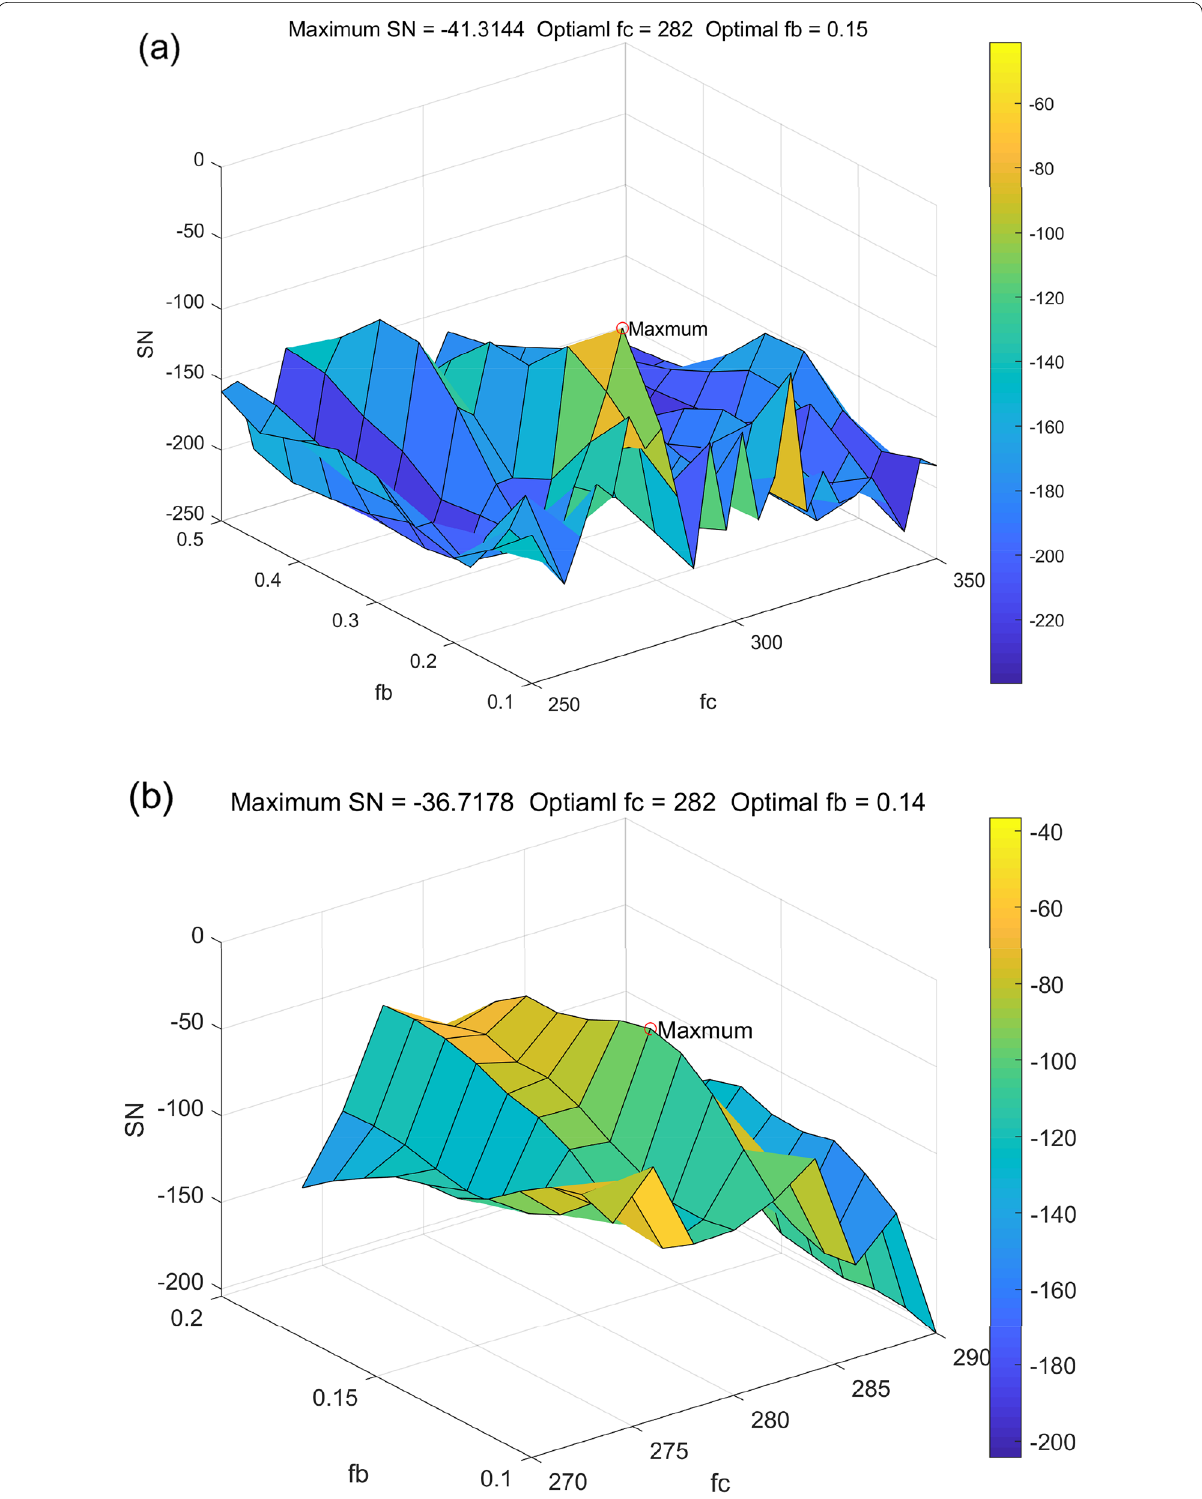
Figure 4 Optimal central frequency and damping ratio obtained by the proposed criterion: ( a ) first iteration results and ( b ) second iteration